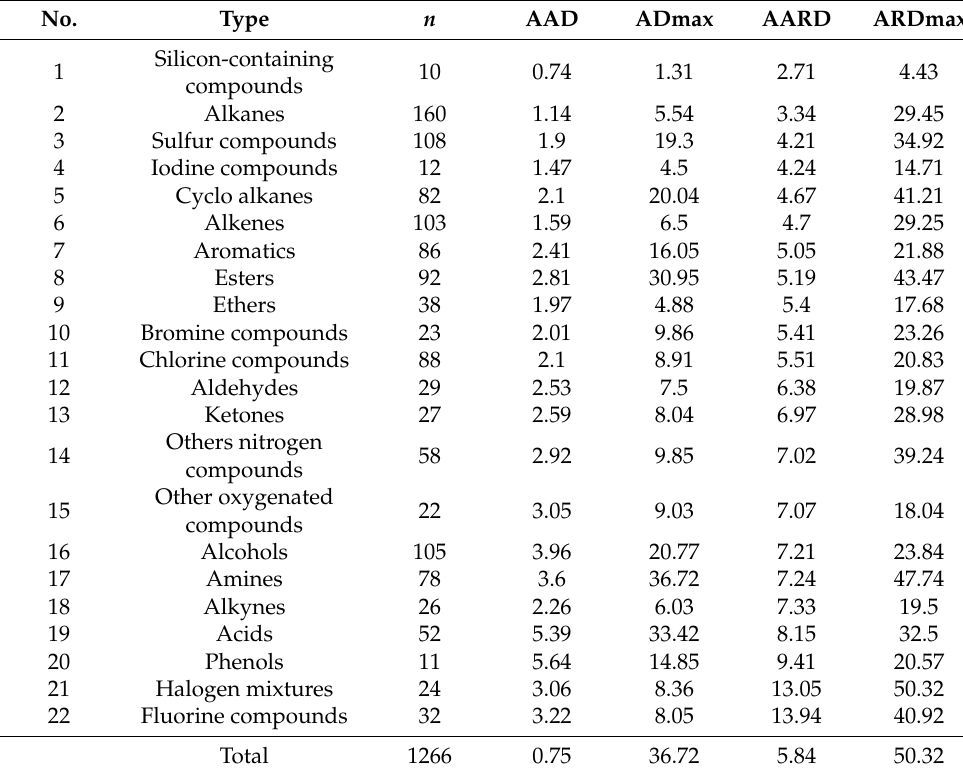
Table 2. Prediction error results for organic compounds involved in the